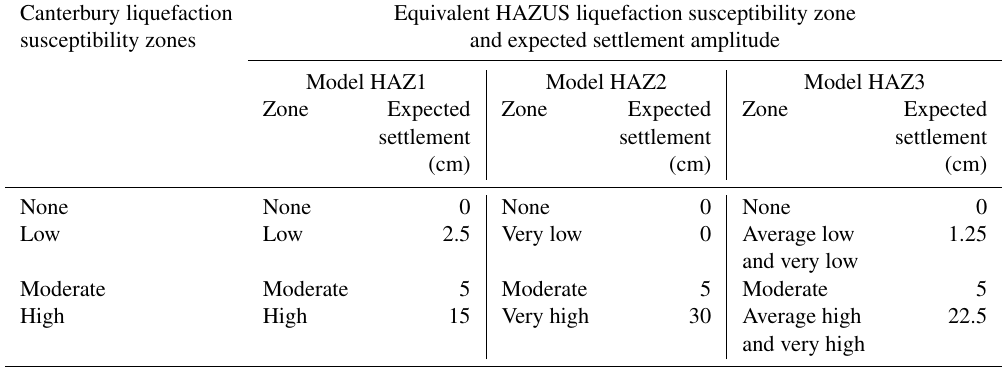
Table 3. Conversion between Canterbury and HAZUS liquefaction susceptibility zones for three implementations of HAZUS method. Refer to Table 4 for descriptions corresponding to model